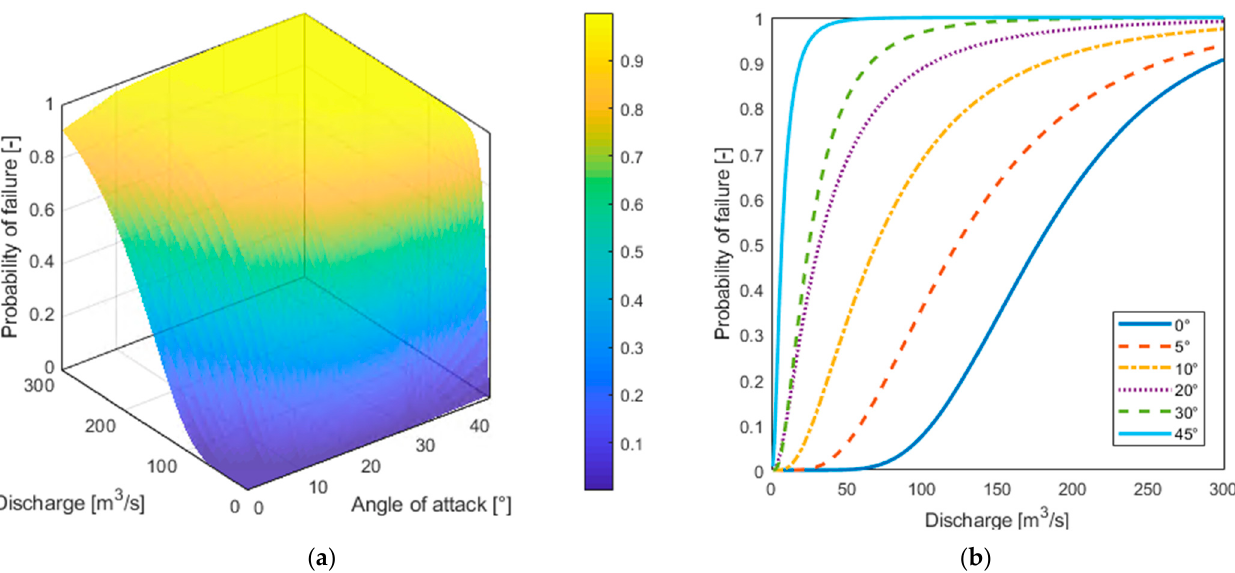
Figure 10. Fragility surface: ( a ) 3D plot; ( b ) Contours.